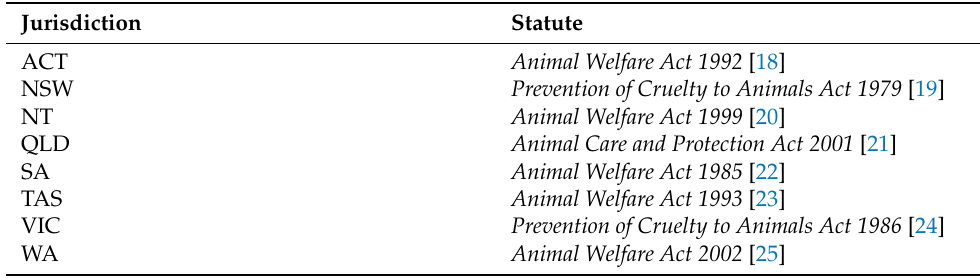
Table 2. Animal welfare statutes for each Australian state and